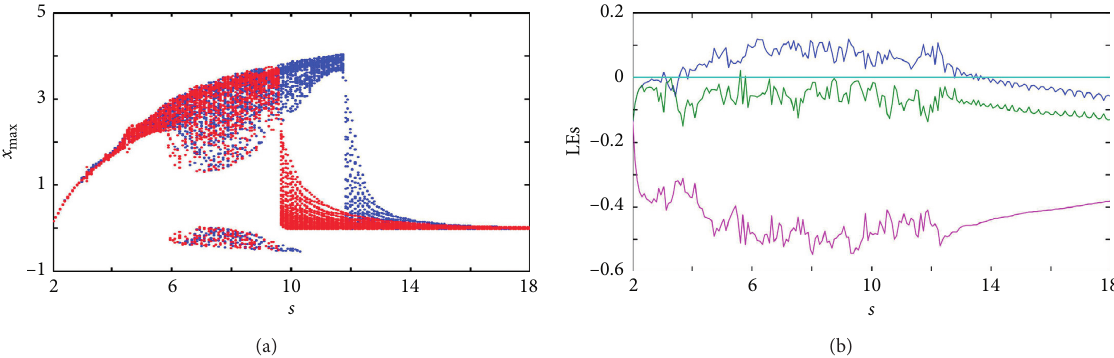
Figure 3: The dynamics of the fractional-order centrifugal flywheel governor system vary with parameter s ; (a) Bifurcation diagram. (b) Lyapunov exponent